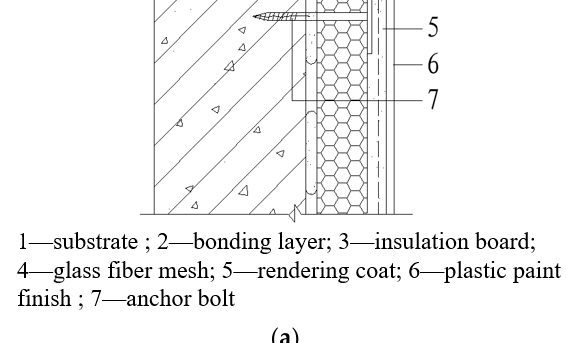
Figure 1. Details of insulation plate ETICS with thin plastering. ( a ) Pasting insulation plate with plastic paint finish. ( b ) Pasting insulation plate with adhesive ceramic tiling.